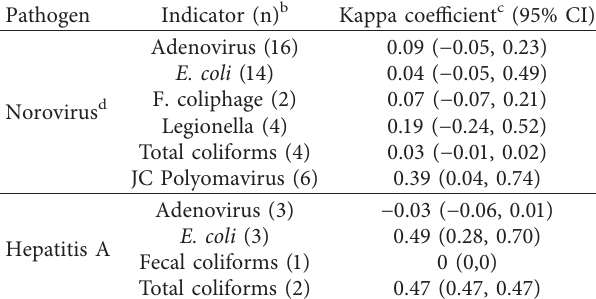
Table 3: Types of pathogen/indicator analyzed by study a .